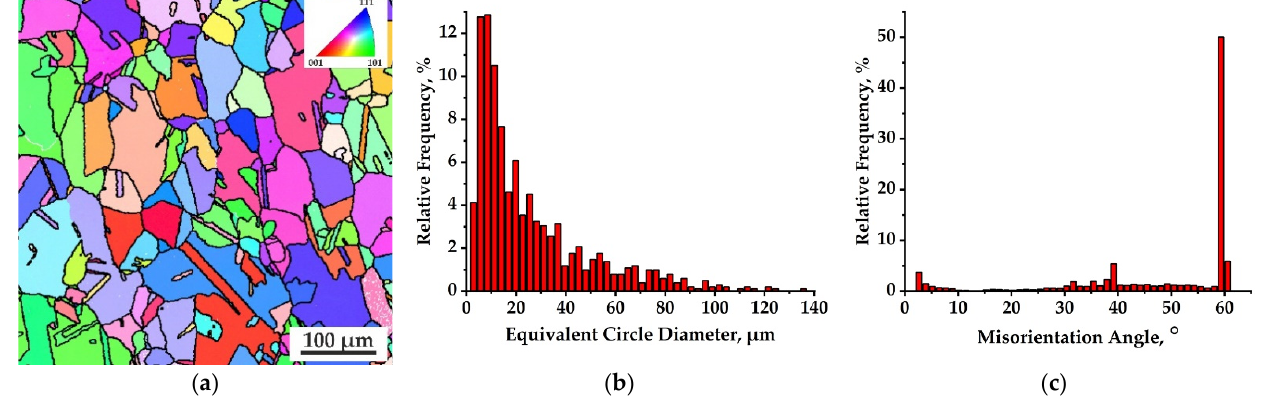
Figure 2. SEM EBSD orientation map with HABs and LABs, denoted by black and white lines, respectively ( a ), histograms of grain size (equivalent circle diameter) distribution ( b ), and grain misorientation distribution of ST steel ( c ).